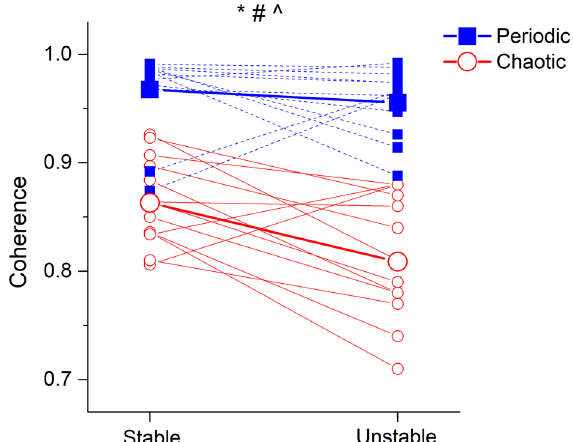
Figure 3. CoP-target coupling: group mean (big symbols—solid line) and individual (small symbols—dashed line) CoP-target coherence values during tracking of the periodic-sinusoidal (blue filled squares) and chaotic- Lorenz (red open circles) target motion on the stable and unstable surface. *Significant surface effect (p < 0.05); # significant target complexity effect (p < 0.05); ^ significant interaction between surface and target complexity (p <